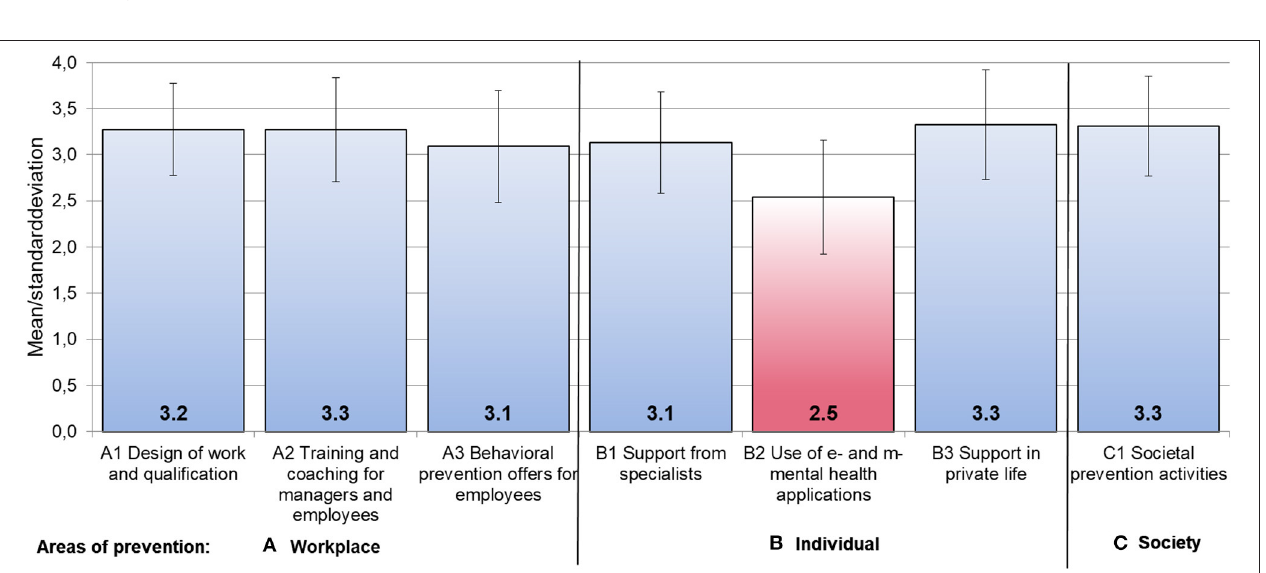
FIGURE 1 | Attributed relevance (M, SD) of diverse prevention strategies at (A) the workplace, for (B) the individual, and in (C) social areas. Mean scores based on 4-point Likert scale from 1 “not relevant at all” to 4 “very relevant”; dimensions resulted from exploratory factor